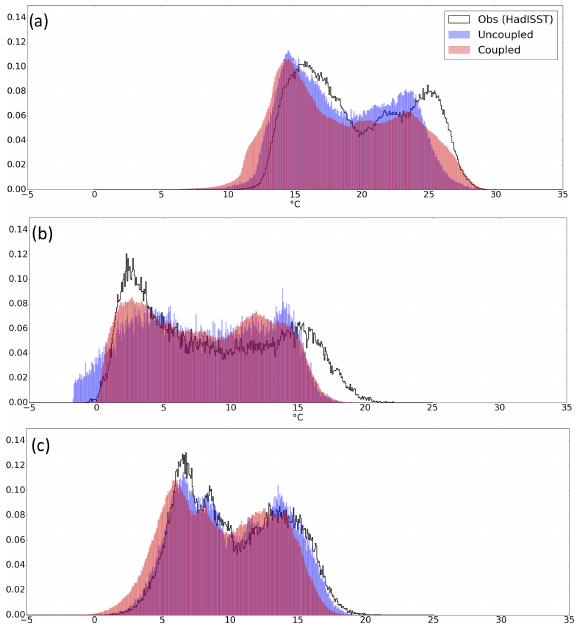
Figure 6. Density histograms of SST values in the marginal seas: (a) Mediterranean Sea, (b) Baltic Sea, and (c) North Sea. Note that in the case of the Baltic Sea the grid points containing sea ice were not considered. CRU is represented in white, the coupled system in red, the uncoupled in blue, and the data overlapping in purple.